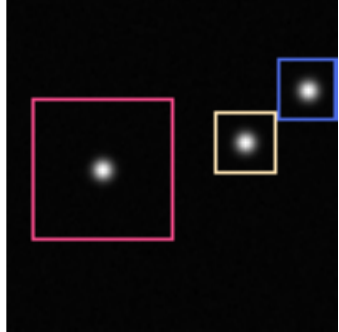
Figure 15. To perform the local fitting to every single particle, we have to split the given image in non-overlapping squares. Here, an example is given with 3 particles. This leads to the 3 marked rectangles—the colored (pink ( (cid:4) ) , yellow ( (cid:4) ) and blue ( (cid:4) ) ) pixels belong to the rectangles. The sizes of the rectangles are: pink 18 × 19 px 2 , yellow 19 × 19 px 2 and blue 43 × 43 px 2